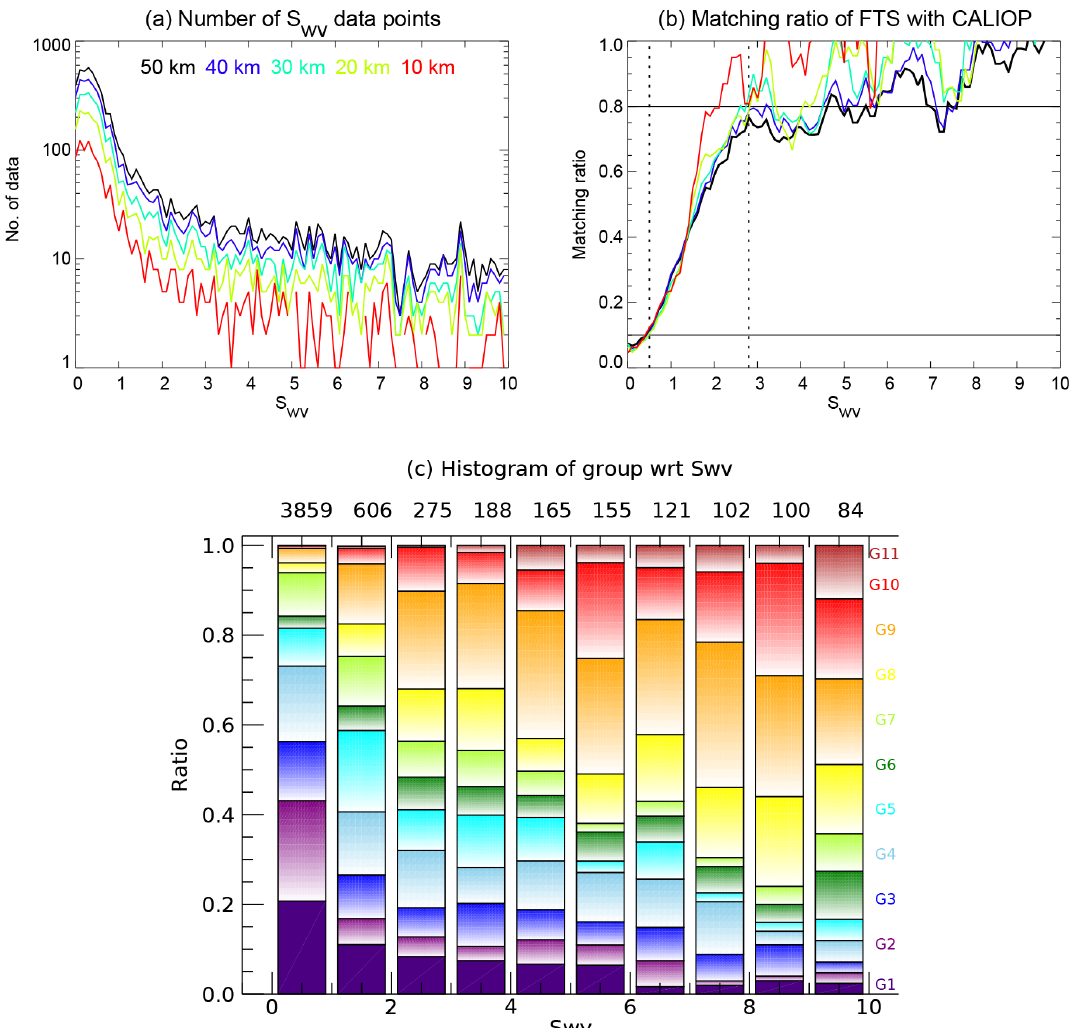
Figure 5. (a) Number of data points as a function of S wv for distance between TANSO-FTS and CALIOP within 10, 20, 30, 40 and 50km. Panel (b) is the same as (a) but for the matching ratio between CALIOP cirrus clouds and TANSO-FTS cloud flag. (c) Histogram of group as a function of S wv for distance between TANSO-FTS and CALIOP within 50km. The color bars indicate the group number from 1 to 12. Group 12 is absent for S wv less than 10.0. The numbers at the top of the graph are the total number in each bin of S wv . The analysis period is from 1 January to 31 December 2010.